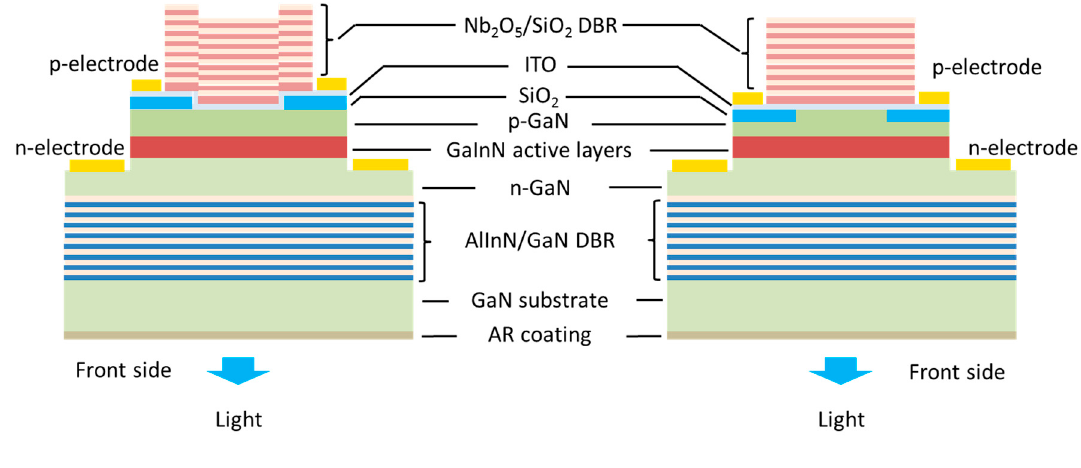
Figure 2. Schematics of the fabricated blue VCSELs with ( a ) simple SiO 2 aperture and ( b ) SiO 2 -buried lateral optical confinement structures.